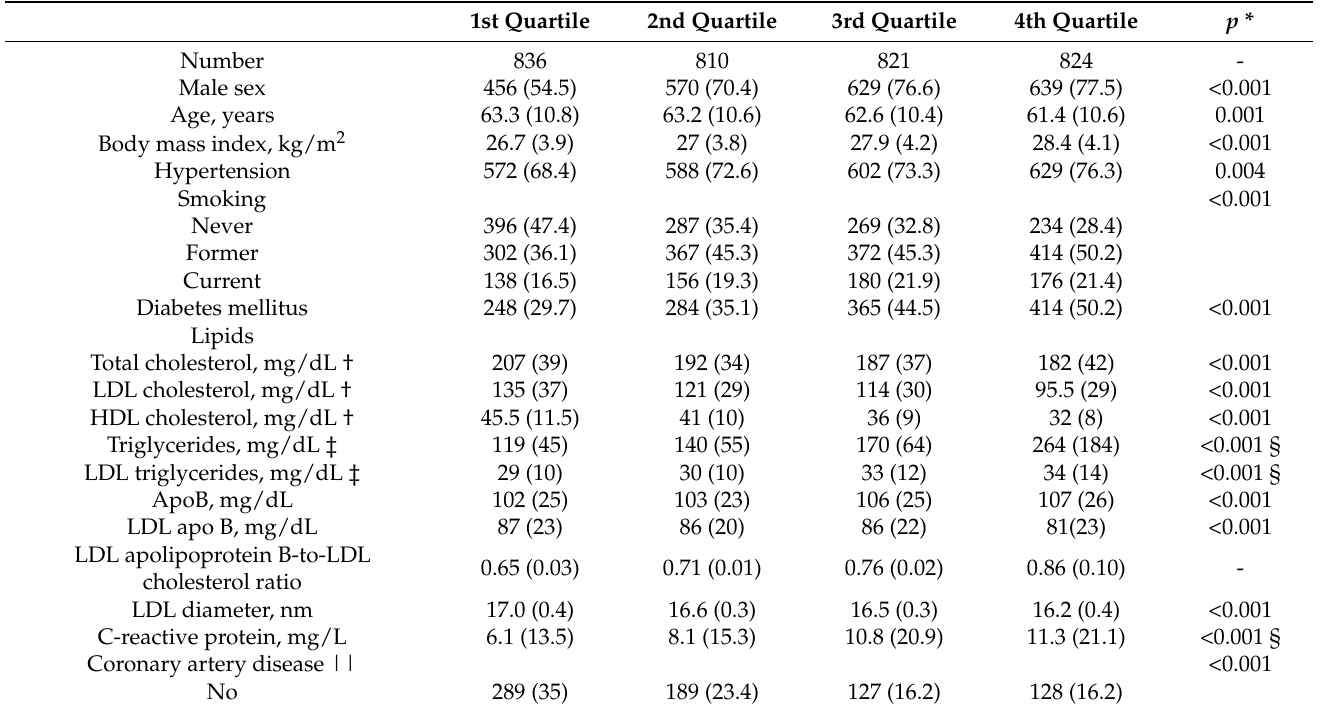
Baseline characteristics according to LDLapoB/LDLC meas quartiles in the entire LURIC